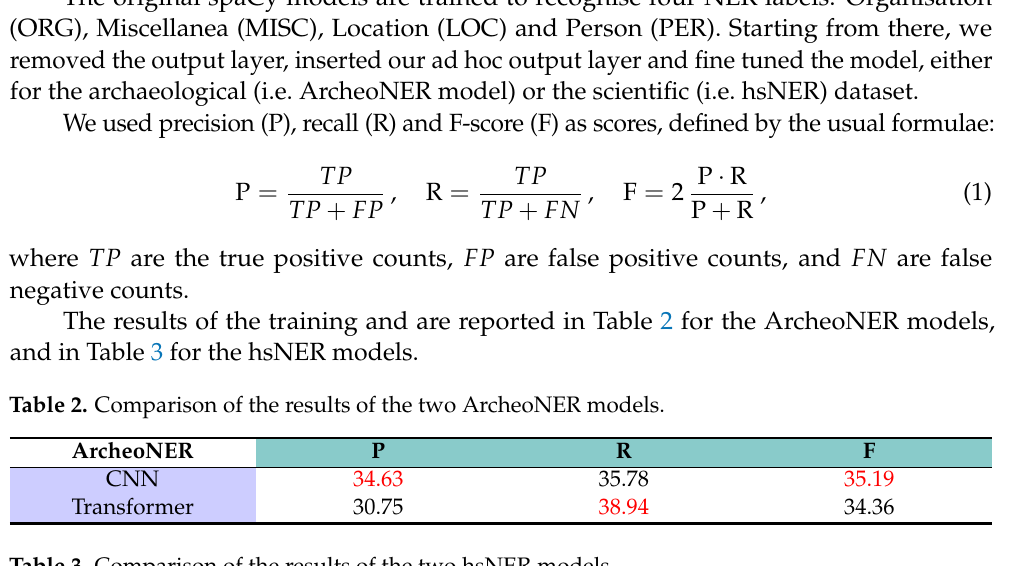
Table 3. Comparison of the results of the two hsNER models.